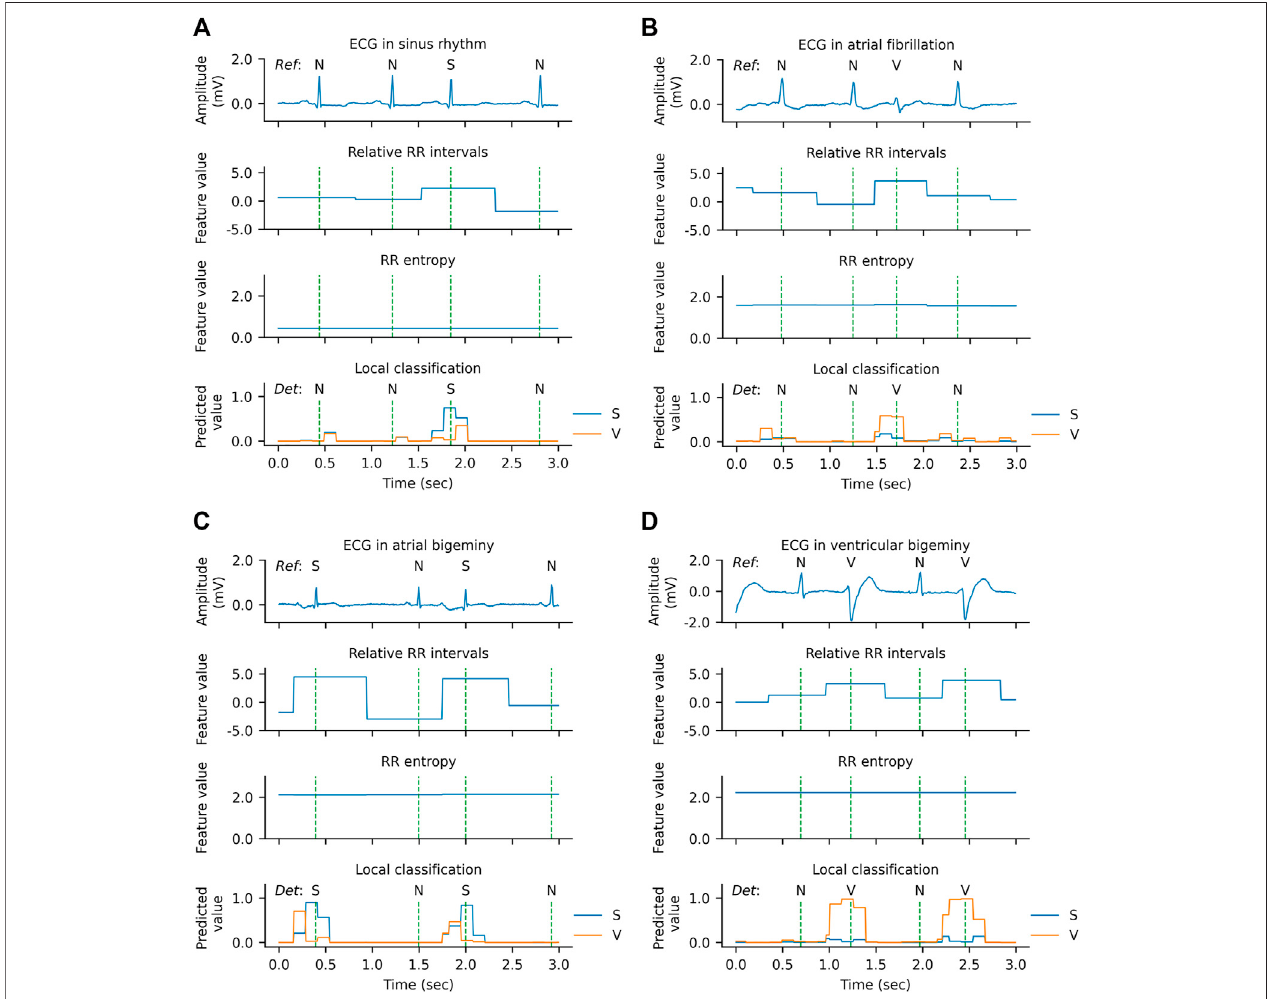
FIGURE 8 | Qualitative results of arrhythmia detection on the MITBIH-AR-DS2 in the SL + WSL setting. (A) An example during normal rhythm. (B) An example during atrial fi brillation. (C) An example during atrial bigeminy. (D) An example during ventricular bigeminy. The vertical dashed lines indicate the positions of R peaks. In the ECG waveform charts, the reference category of each heartbeat is labeled above the ECG. In the local classi fi cation charts, the predictions for supraventricular ectopic beats (S) are drawn in blue, the predictions for ventricular ectopic beats (V) are drawn in orange, and the detected categories are labeled above the predictionlines.Ndenotesanormalorbundlebranchblockbeat.SincetheprobabilitiesofN,S,andVadduptooneateachsamplingpoint,thepredictionsforNarenot plotted in the fi gure for clarity.